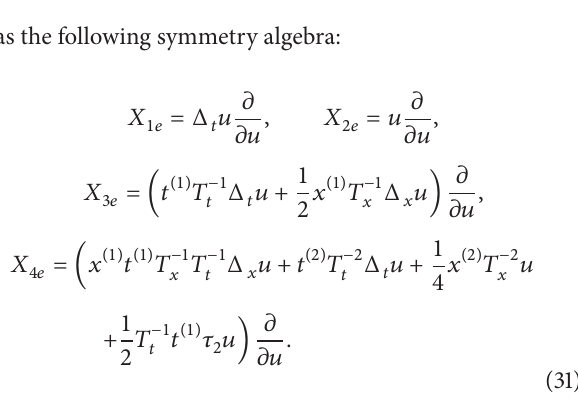
Table 3: The optimal systems for discrete centrifugal barrier and respective invariant